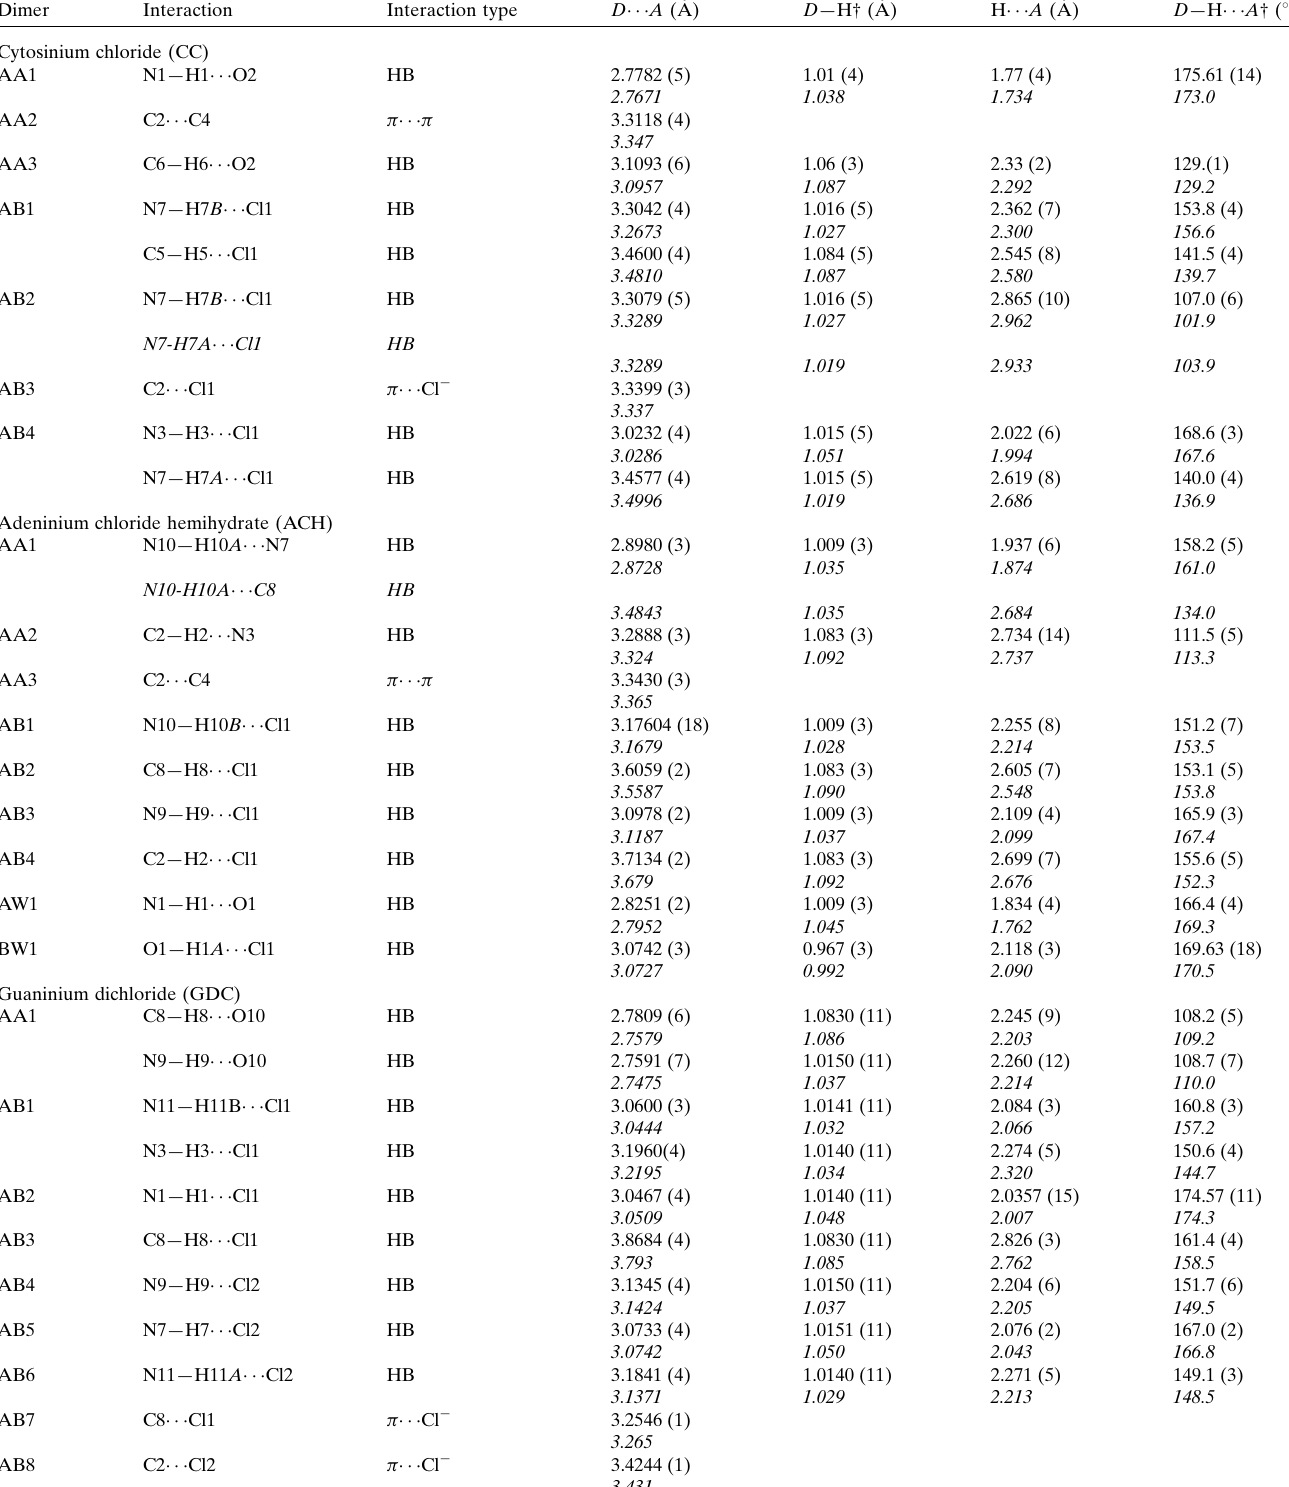
Table 3 Intermolecular contacts in the CC, ACH and GDC structures that are shorter than the sum of the van der Waals radii (Bondi, 1964), as established from experiment (upper values in each entry) and from periodic optimization of crystal geometry (lower values in each entry, in italics). For the symmetry operations required to build particular dimers, see Table S2 in the supporting information. In the ‘Interaction type’ column, HB denotes a hydrogen bond. Dimer